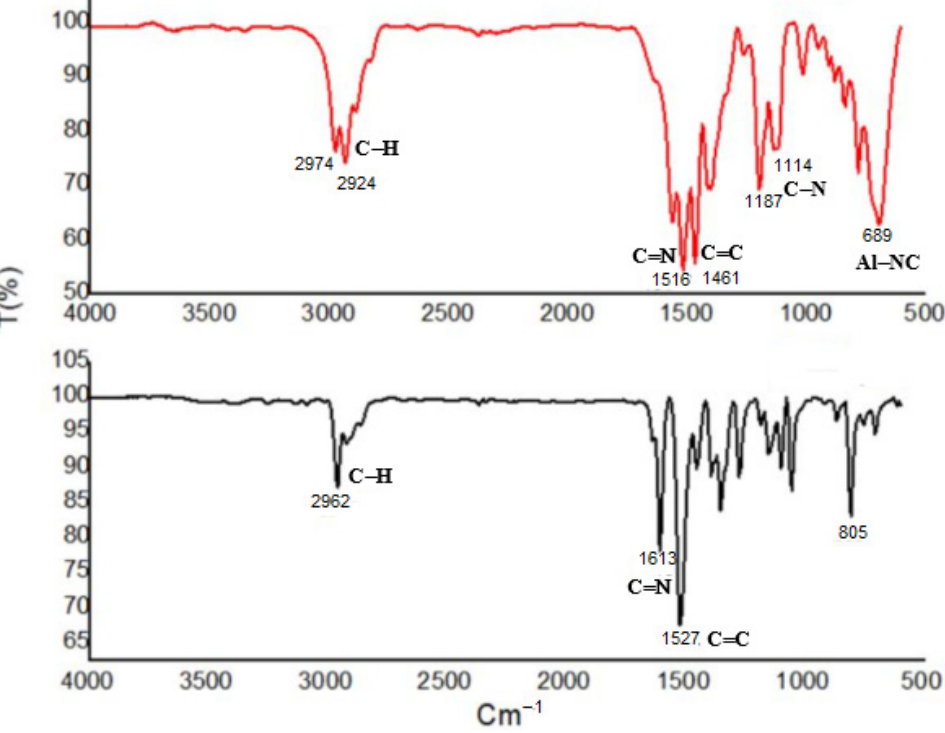
Figure 4. FT-IR spectrum for alkyl aluminum adduct 1 (red) versus benzodiimidazole-diylidene ligand L 1 (black).